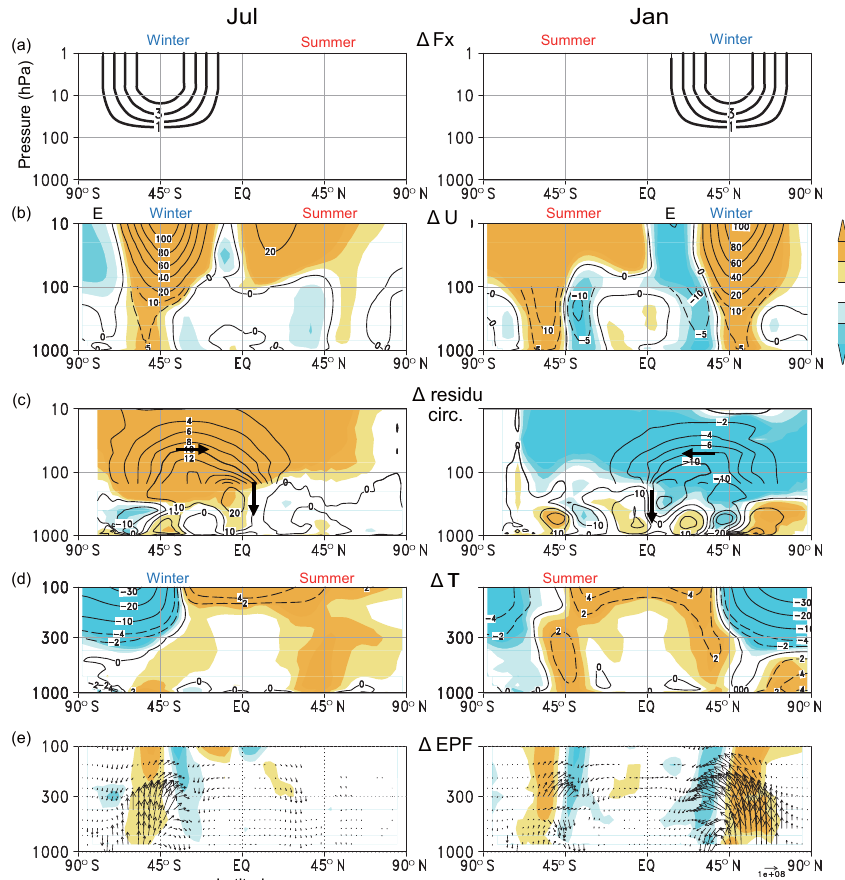
Figure 12. Difference between strong and weak stratospheric westerly jet experiments by Yukimoto and Kodera (2007) in July (left) and January (right): (a) zonal momentum forcing (ms − 1 day − 1 ), (b) zonal mean zonal winds (ms − 1 ) , (c) mean meridional residual circulation (10 9 kgs − 1 ) , (d) zonal mean air temperature (K) and (e) E–P fluxes (m − 2 s − 2 ) (arrows) and their divergence (colour shading). Colour shading indicates differences normalized by the standard